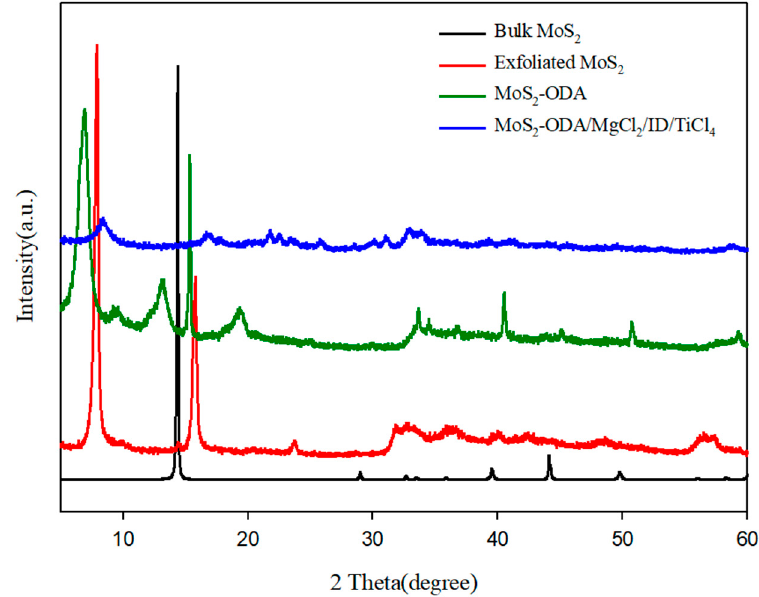
Figure 3. X-ray di ff raction (XRD) pattern of bulk MoS 2 , exfoliated MoS 2 , MoS 2 -ODA, and Figure 3. X-ray diffraction (XRD) pattern of bulk MoS 2 , exfoliated MoS 2 , MoS 2 -ODA, and MoS 2 - MoS 2 -ODA / MgCl 2 / ID / TiCl 4 ODA/MgCl 2 /ID/TiCl 4 .